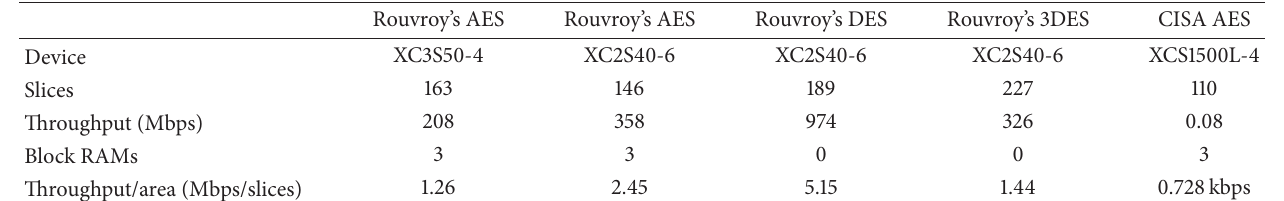
Table 10: Comparison with other Rouvroy et al.’s designs in terms of code execution and speed.